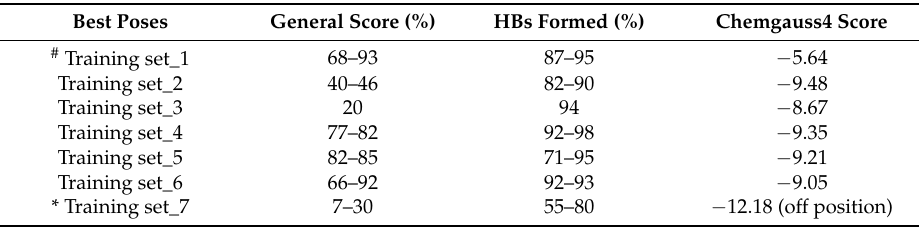
Table 1. Summary statistics for our study groups.